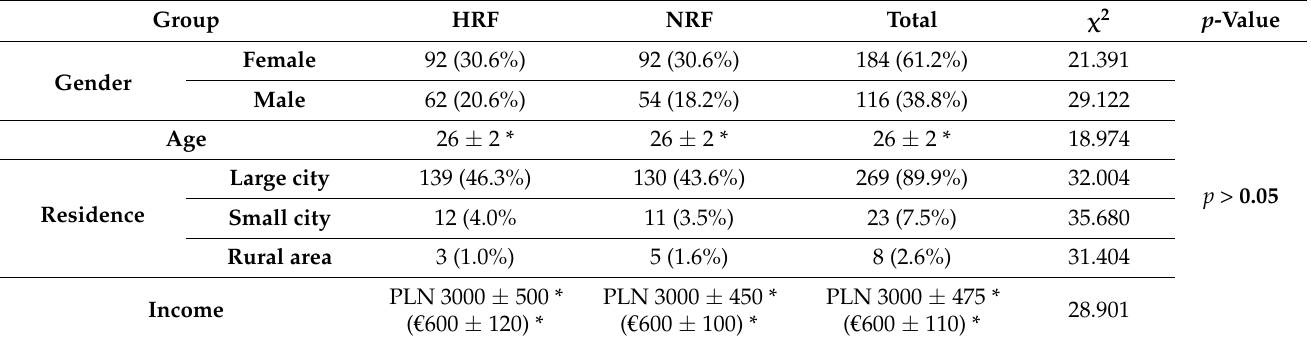
Table 1. Comparison of the studied groups (N = 300; HRF = 150; NRF =